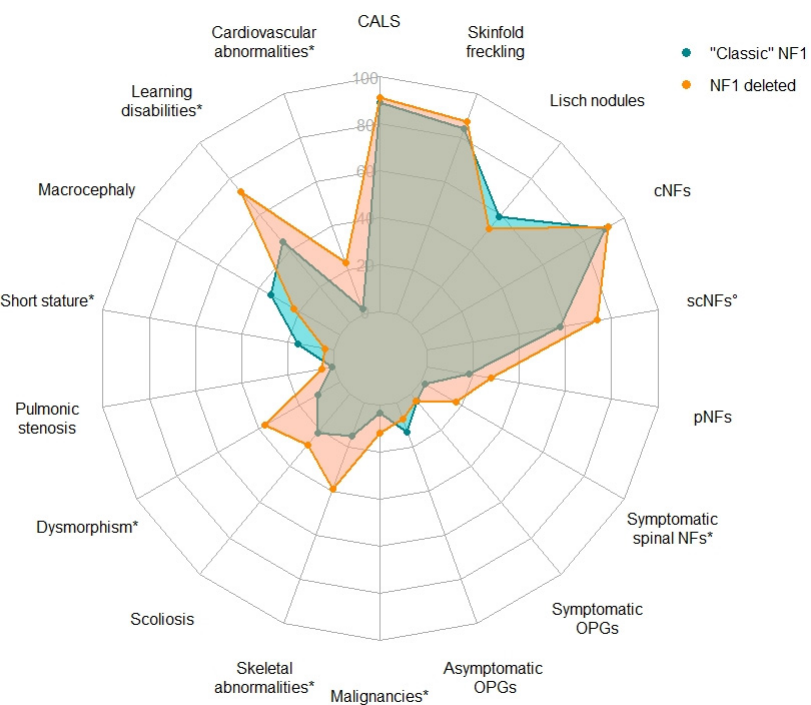
Figure 1. Radar chart of the frequency of the main clinical findings in the French NF1 -deleted cohort and in “classic” NF1. Frequency of features with a white circle ( ◦ ) or an asterisk (*) significantly differ between the two cohorts, respectively only before or after correction for multiple testing with the Benjamini-Hochberg (B-H) procedure. CALS: caf é -au-lait spots; cNFs: cutaneous neurofibromas; OPGs: optic pathway gliomas; pNFs: plexiform neurofibromas; scNFs: subcutaneous neurofi- bromas.